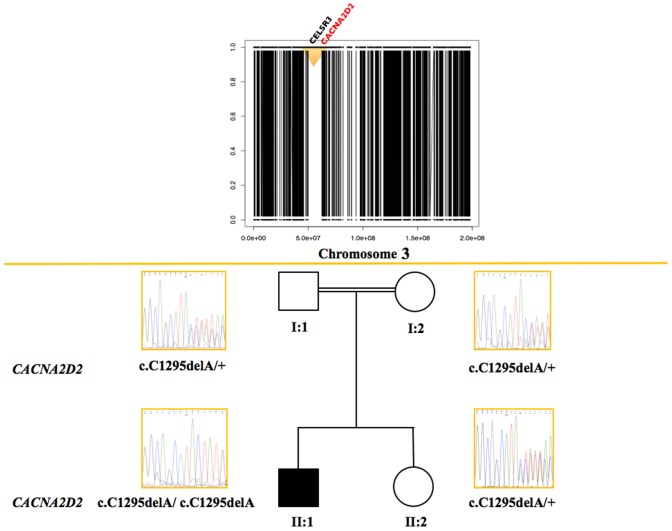
Genetic mapping and segregation of CACNA2D2 c.C1295delA mutation.Upper panel: barcode plot showing EX-HOM on chromosome 3. If the SNP is heterozygous, y = 0, if it is homozygous y = 1. Black bars represent regions of mixed heterozygous/homozygous SNPs, whilst white bars regions of contiguous homozygous SNPs. Different colors reflect the type of mutation: CELSR3 has a missense variant (black), CACNA2D2 has a loss-of-function variant (red). Lower panel: the CACNA2D2 c.C1295delA mutation segregates with the disease in the nuclear pedigree (parents are 1st cousins).